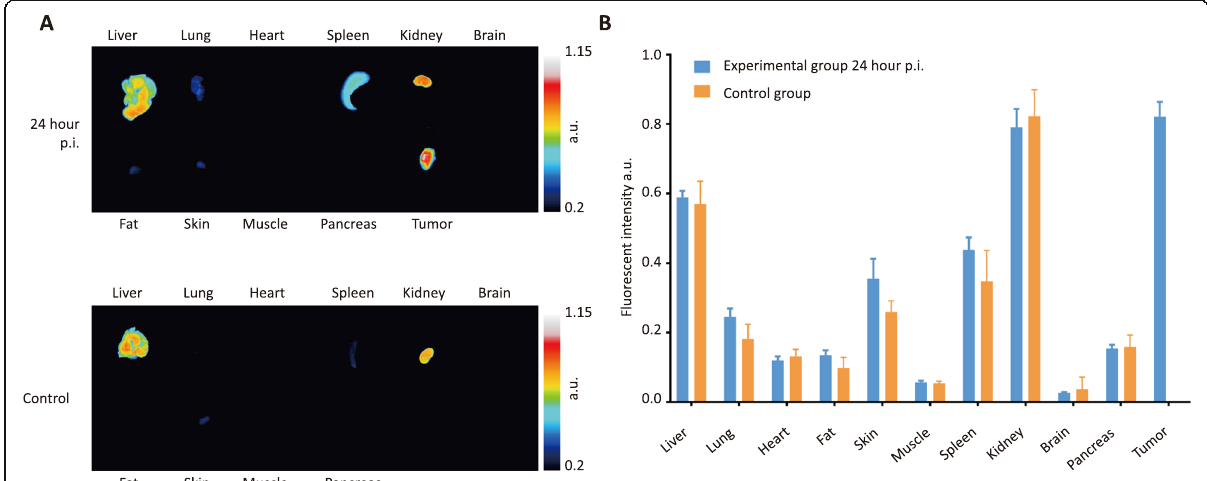
Fig. 3 Comparable pattern in VGT-309 organ biodistribution between the experimental mice (24 h post injection group) and the control mice. a Representative fluorescent images of tissues from the experimental mice (upper panel) and the control mice (lower panel). b Quantitative fluorescent signal of a . n = 6. Data are presented as mean ± standard error. An independent Student ’ s T test did not find significant differences between